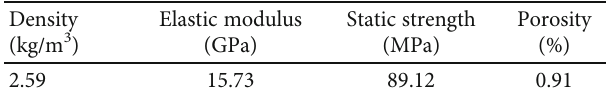
Table 1: Mechanical properties of granites. Density (kg/m 3